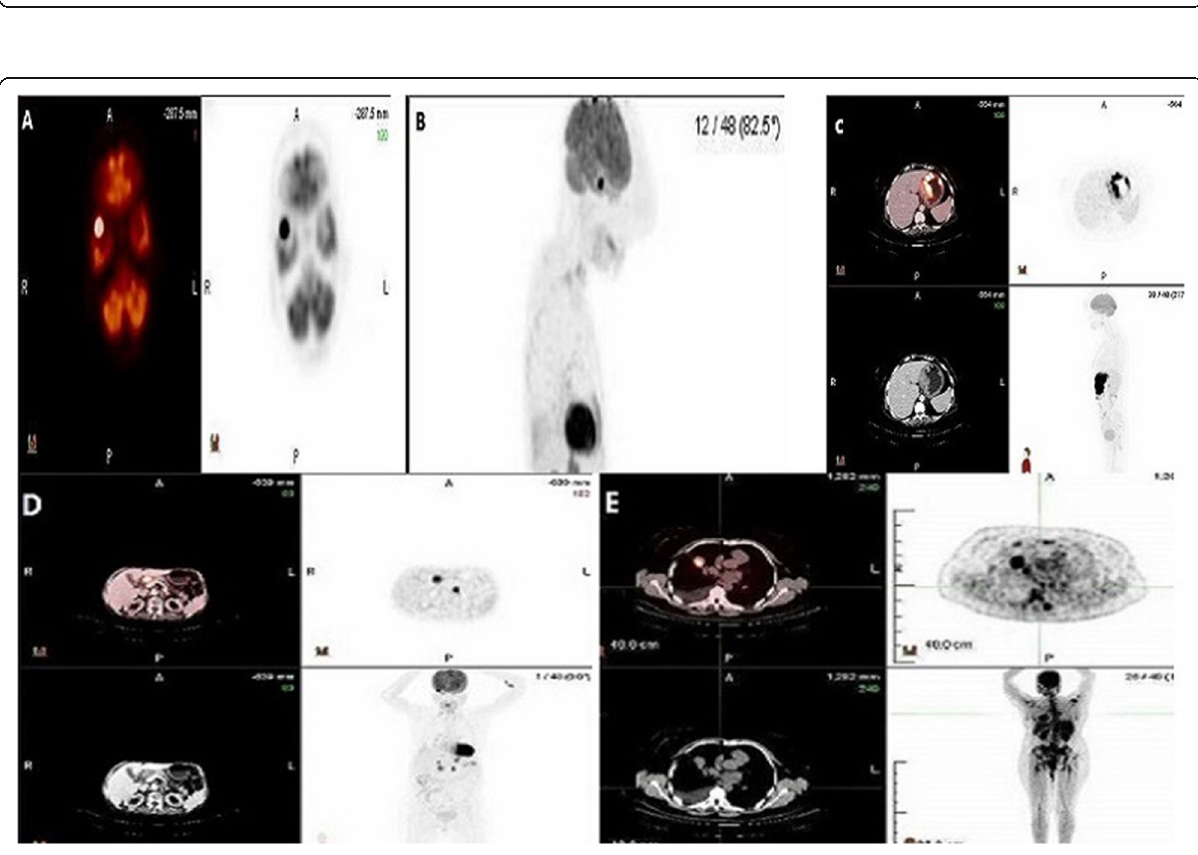
Fig. 2 Kaplan – Meier analysis in 19 patients in whom the primary tumor was detected and 20 patients with unidentified tumor. OS, overall survival